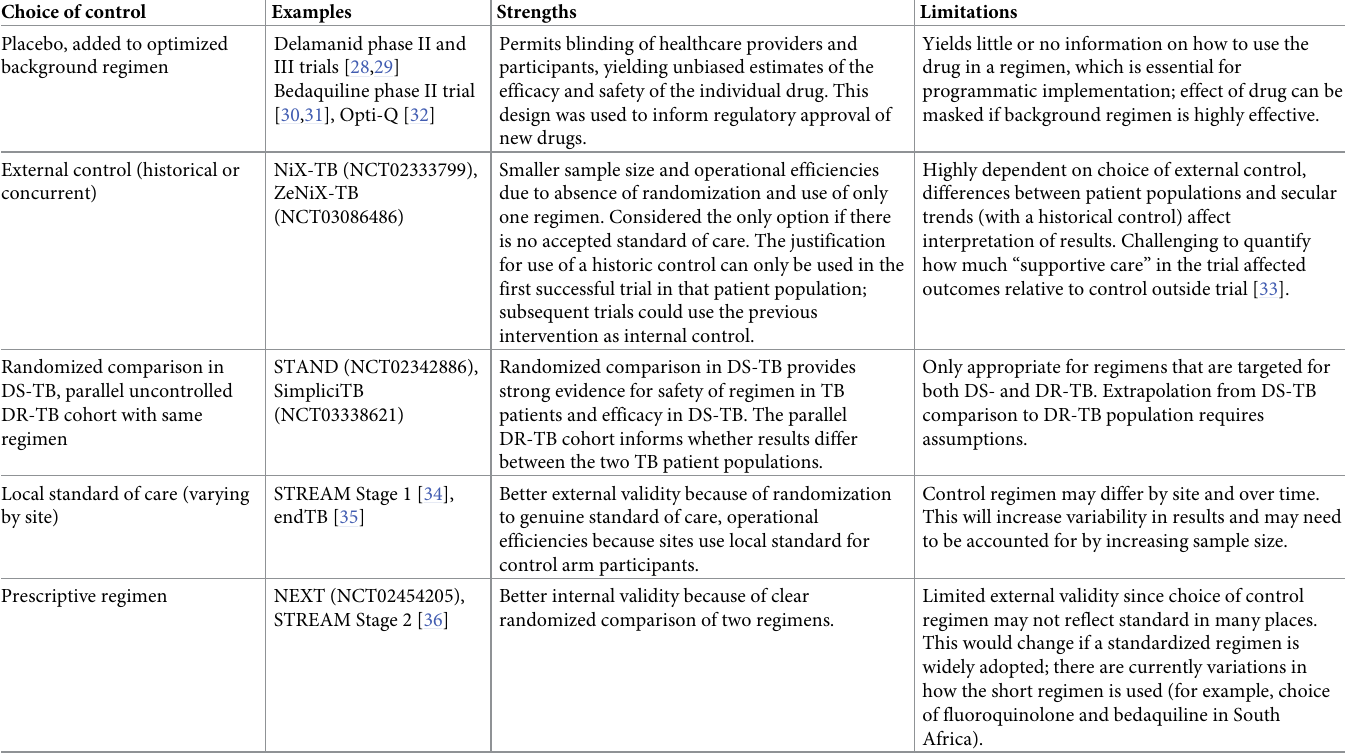
Table 2. Controls used in DR-TB